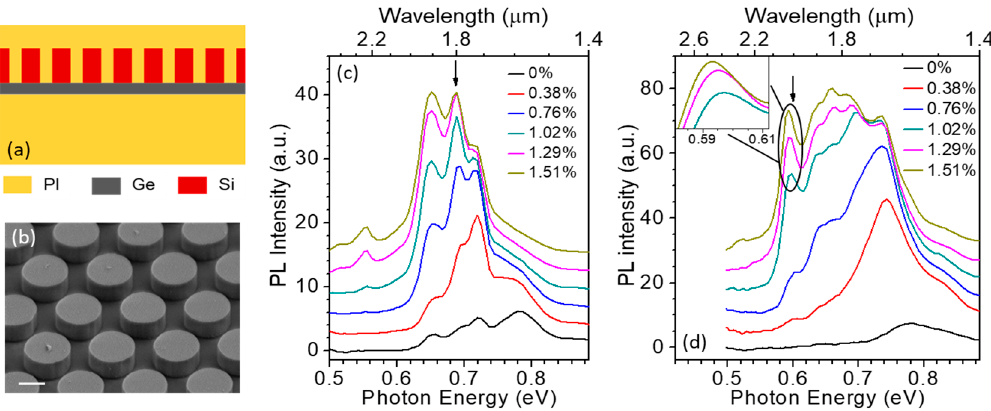
Figure 5. Flexible photonic-crystal cavities for tensilely strained Ge NMs. ( a ) Schematic device cross section; ( b ) SEM image of a Si-pillar array before transfer onto a Ge NM on PI. The scale bar is 500 nm; ( c , d ) Strain-resolved room-temperature PL spectra measured on two Ge(001) samples with different column periods a and diameters D: ( c ) a = 1060 nm, D = 850 nm; ( d ) a = 1340 nm, D = 950 nm. Inset of ( d ): zoom-in of the features within the black ellipse, showing strain tuning of the cavity modes. The arrow in each plot indicates the calculated photon energy of the main TM-polarized cavity resonance. ( b – d ): Reproduced with permission from [28]. AIP Publishing LLC, 2016.